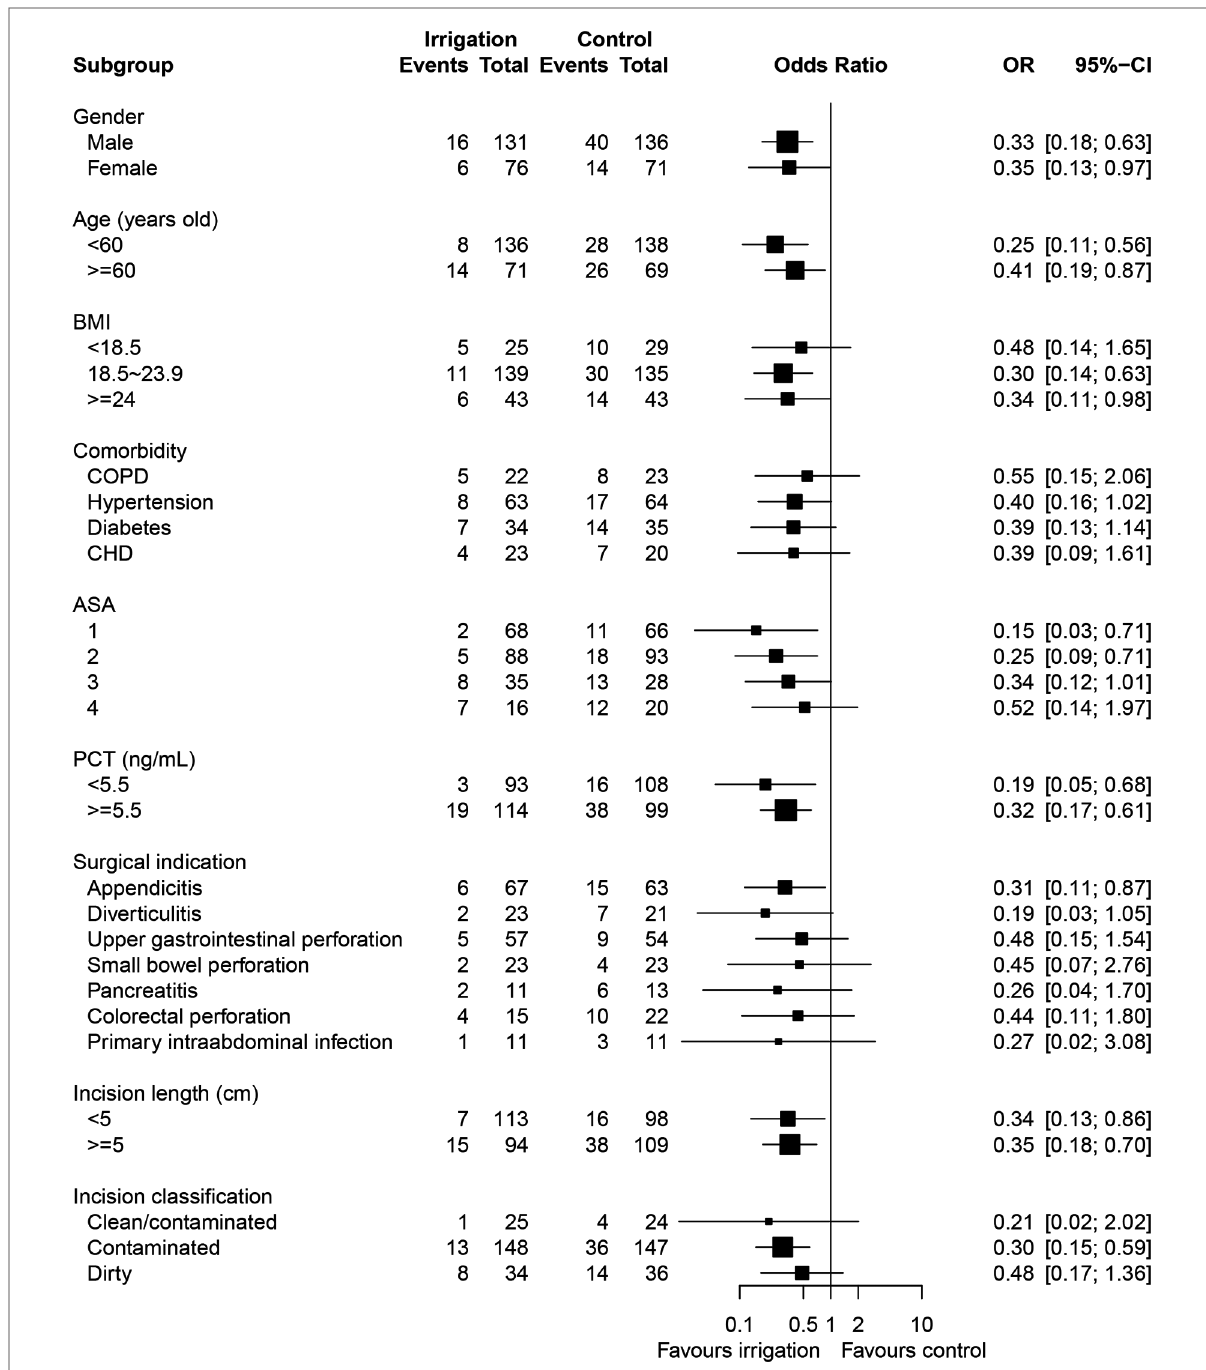
FIGURE 2 Subgroup analysis for surgical site infection in the irrigation group as compared with the control group, assessed by logistic regression analysis with adjustment for the strati fi cation